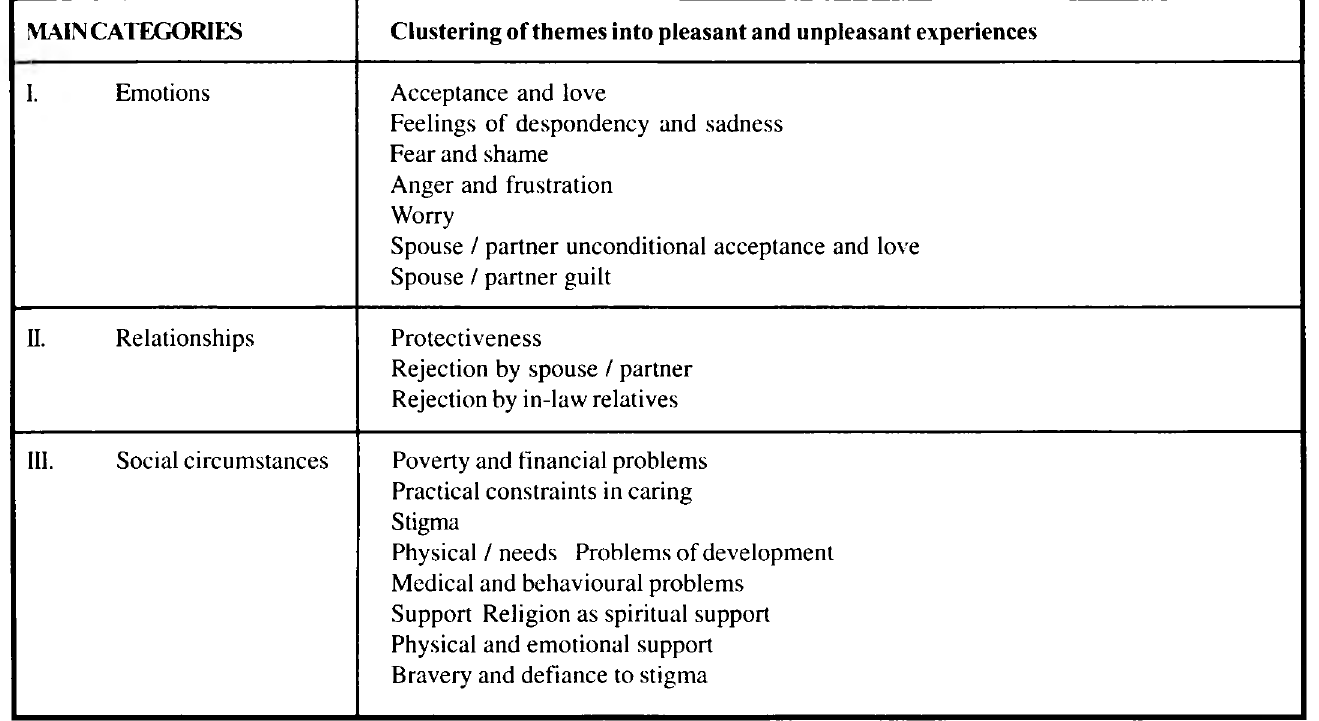
Tabel 1.2: Experiences of mothers caring for mentally retarded children in a township (N=12) MAIN